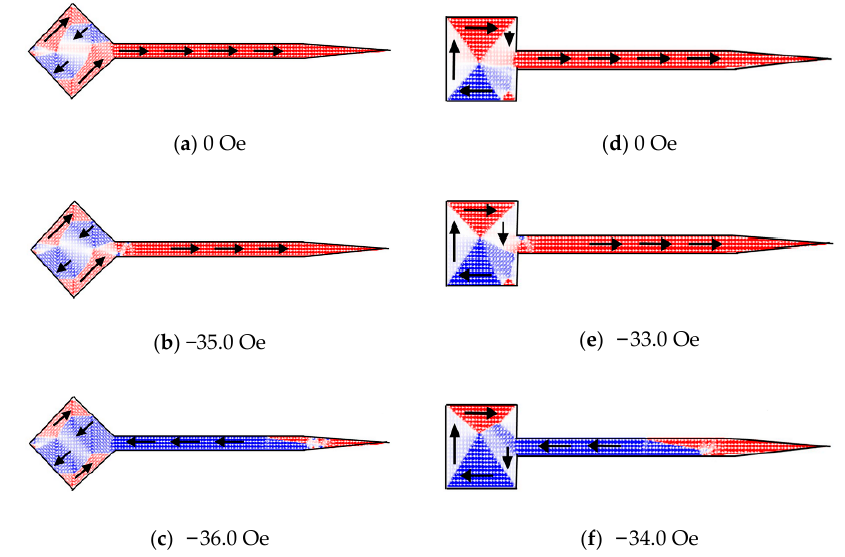
Figure 4. Simulated configuration of permalloy with a diamond and square shapes: ( a ) A two-vortex wall formation; ( b ) The DW injection in the nanostrip; ( c ) The DW movement in the nanostrip; ( d ) A closed domain formation; ( e ) The DW injection in the nanostrip; ( f ) The DW moving in the nanostrip.